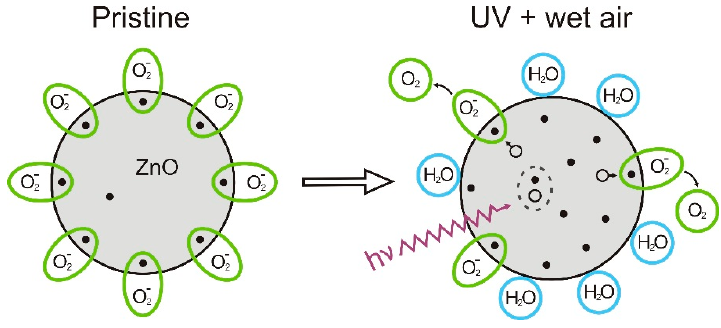
Figure 2. Schematic model of the stabilization of the ZnO nanoparticles.